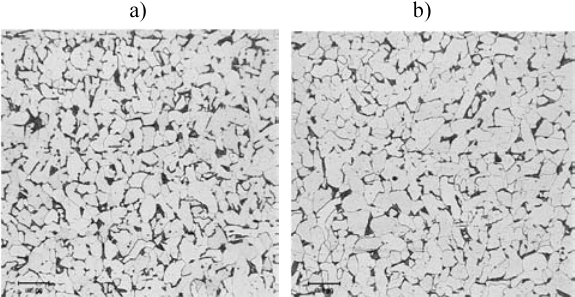
Fig. 5. Microstructure of examined sheets, magnified 200 times, etched with Nital solution: a) sheet from tank No. 3, b) sheet from tank No. 4